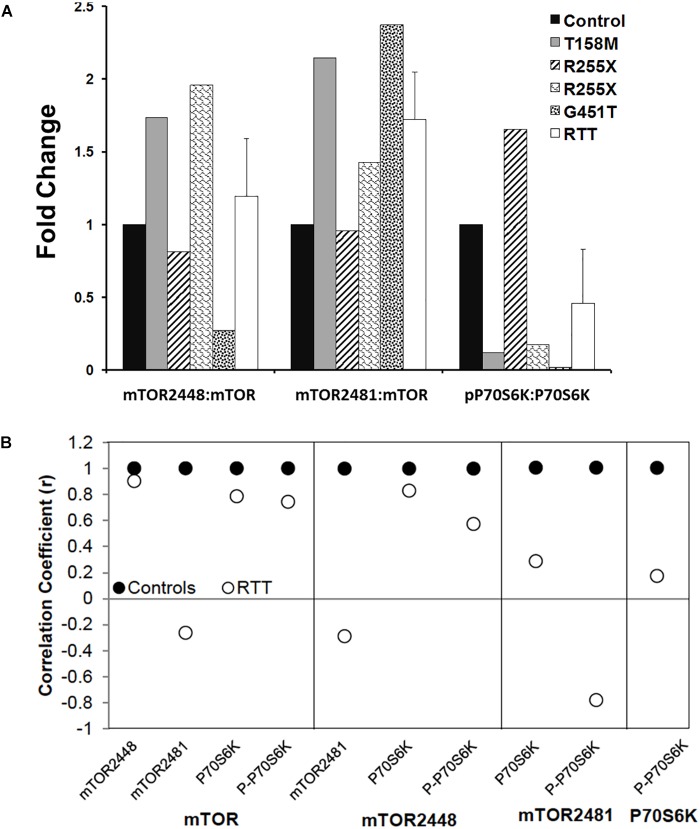
Ratios and correlations of phosphorylated to total protein in Rett syndrome. (A) The ratio of individual phosphorylated proteins to the total proteins for indicated molecules is shown. N = 3 ± SEM for controls, N = 4 ± SEM for RTT patients. (B) Correlation coefficients for phosphorylated proteins to total proteins for indicated molecules are shown.